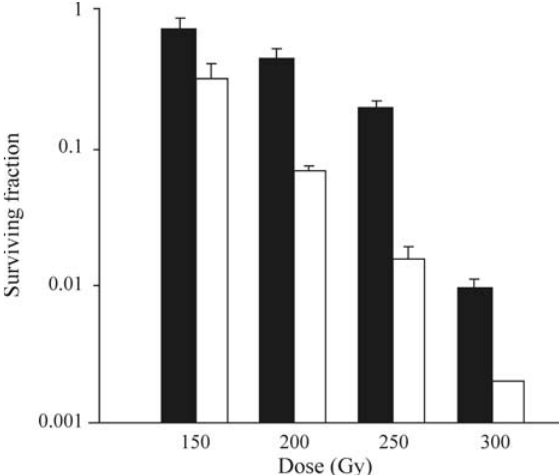
Figure 3 - Adaptive response measured as cell surviving fraction in the ra- dioresistantstrain Chlamydomonasreinhardtii H-3.Theeffect ofacondi- tioning dose (150 Gy) on the response of cells given a series of test doses four hours later is shown. ( ❏ ) with conditioning dose (150 Gy); ( ■ ) with- out conditioning dose. Modified from Chankova et al.